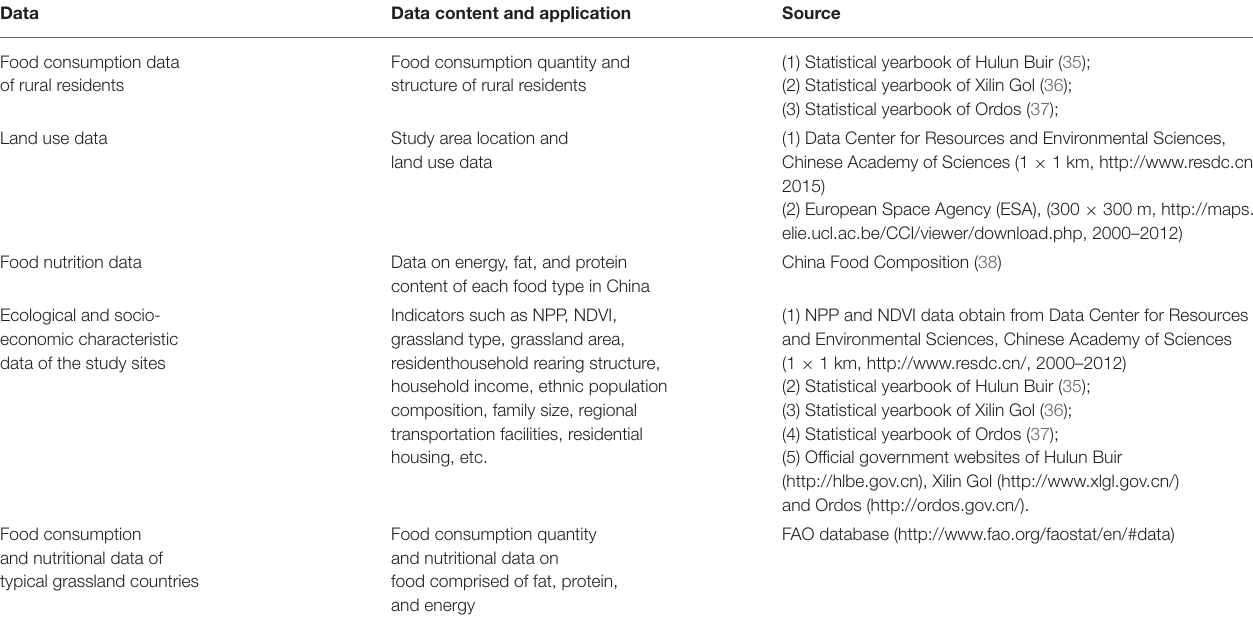
TABLE 2 | Data and sources used in this